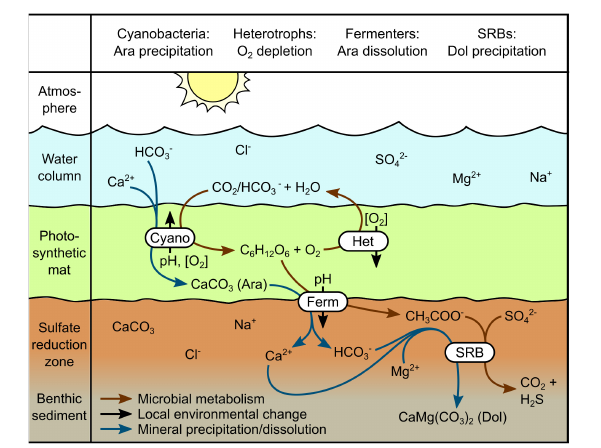
FIGURE 7 | Proposed model for the formation of aragonite and dolomite in mats and sediments in Great Salt Lake (GSL). Photosynthesis in benthic cyanobacterial mats generates a local increase in alkalinity, promoting the precipitation of aragonite on extracellular polymeric substances, as well as generating large quantities of biomass and O 2 . Aerobic heterotrophs oxidize sufficient biomass and photosynthate to deplete local O 2 , generating a niche for anaerobic fermentative bacteria and sulfate-reducing bacteria (SRB). Organic acids produced by fermenters both lower porewater pH, promoting aragonite dissolution, and provide substrates supporting heterotrophic SRB in underlying sediments. SRB activity promotes dolomite precipitation in mildly acidic microenvironments where aragonite precipitation is thermodynamically disfavored. Abbreviations: Ar, aragonite; Do, dolomite; Cyano,